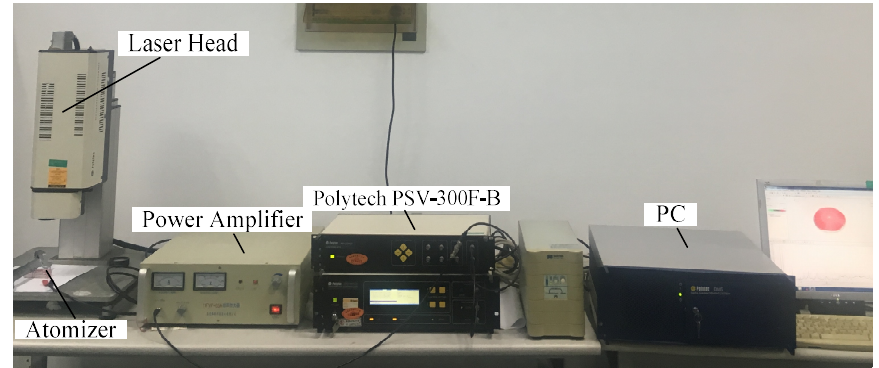
Figure 4. Photograph of the equipment for measuring the vibration mode of the piezoelectric vibrator [29].